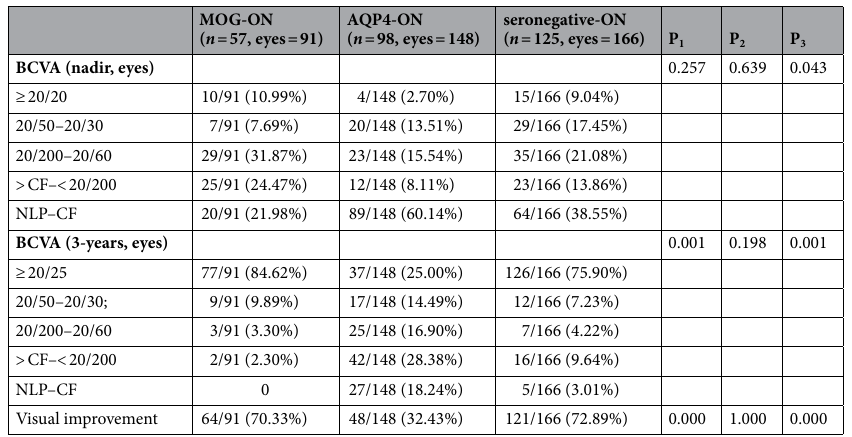
Table 2. Best-corrected visual acuity in the three groups of patients with optic neuritis. MOG, myelin oligodendrocyte glycoprotein; AQP4, aquaporin-4; ON, optic neuritis; BCVA, best-corrected visual acuity; NLP, no light perception; CF, counting fingers; P 1 , P value MOG-ON compared to AQP4-ON; P 2 , P value MOG-ON compared to seronegative-ON; P 3 , P value AQP4-ON compared to seronegative-ON. Snellen chart was revised for use in China: 0.8 = 20/25; 0.4 = 20/50; 0.7 = 20/30; 0.3 = 20/60; 0.1 = 20/200; counting fingers; no light perception.